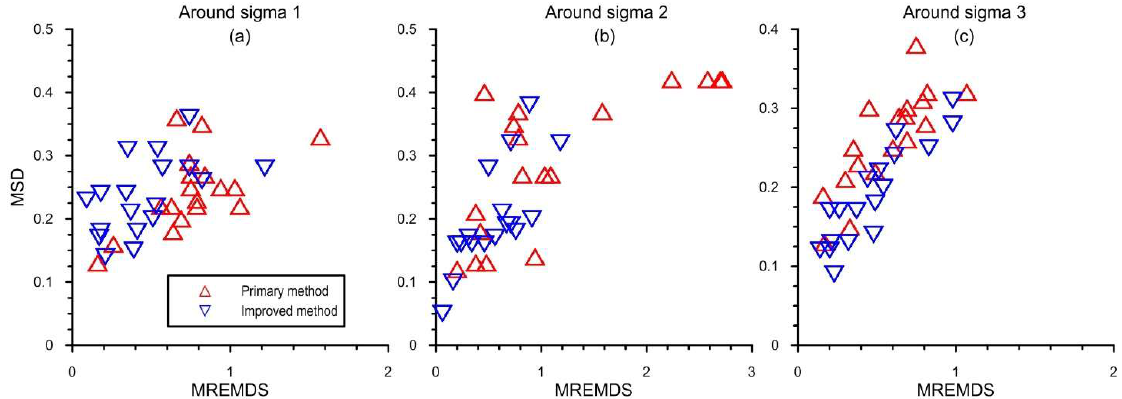
Figure 6. The MSD vs. the MREMDS for NC = 60 in the case of rotation around (a) σ 1 , (b) σ 2 , and (c) σ 3 , respectively.